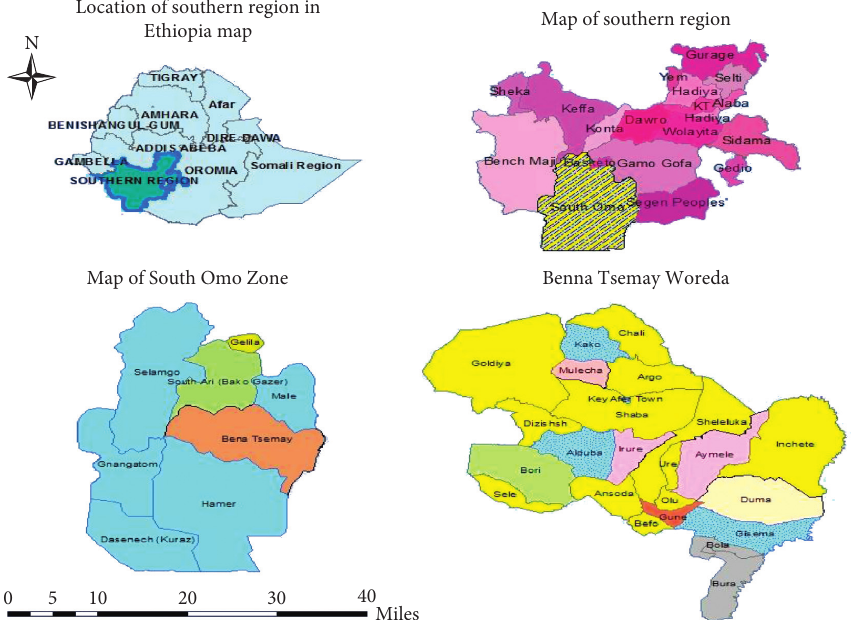
Figure 1: Administrative map of Benna Tsemay Woreda, South Omo Zone, Southern Ethiopia,